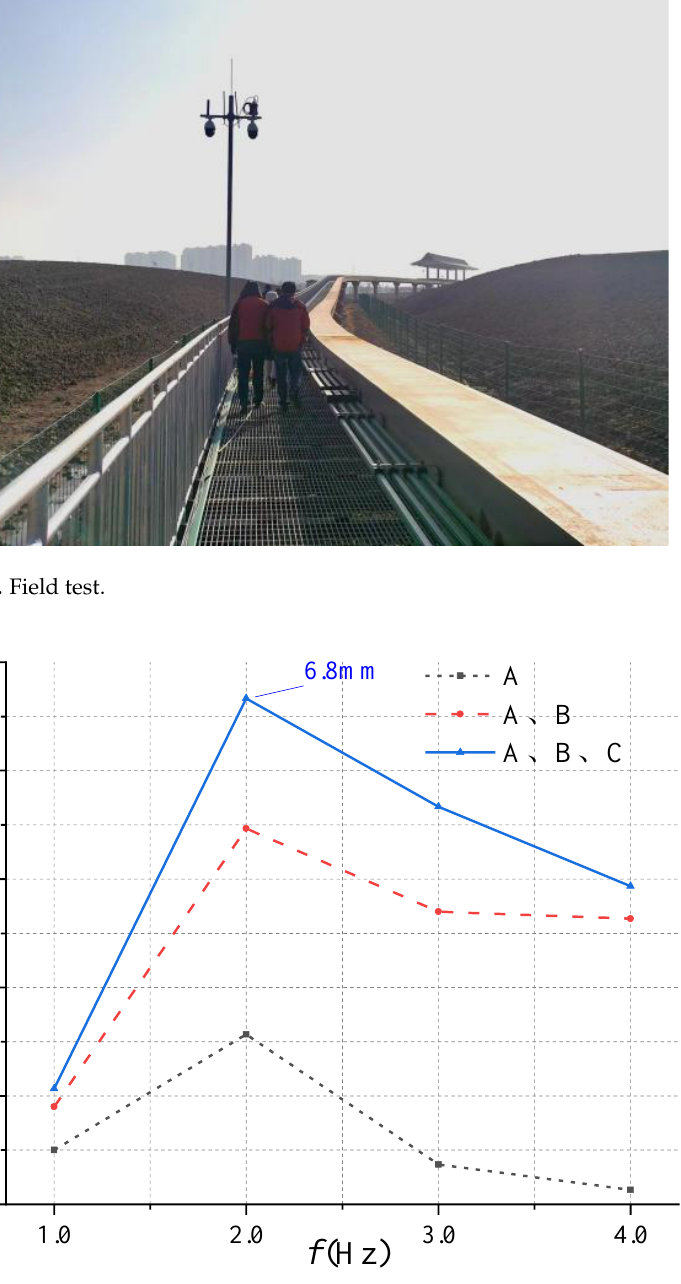
Figure 9. Lateral Figure 9. Lateral amplitude.